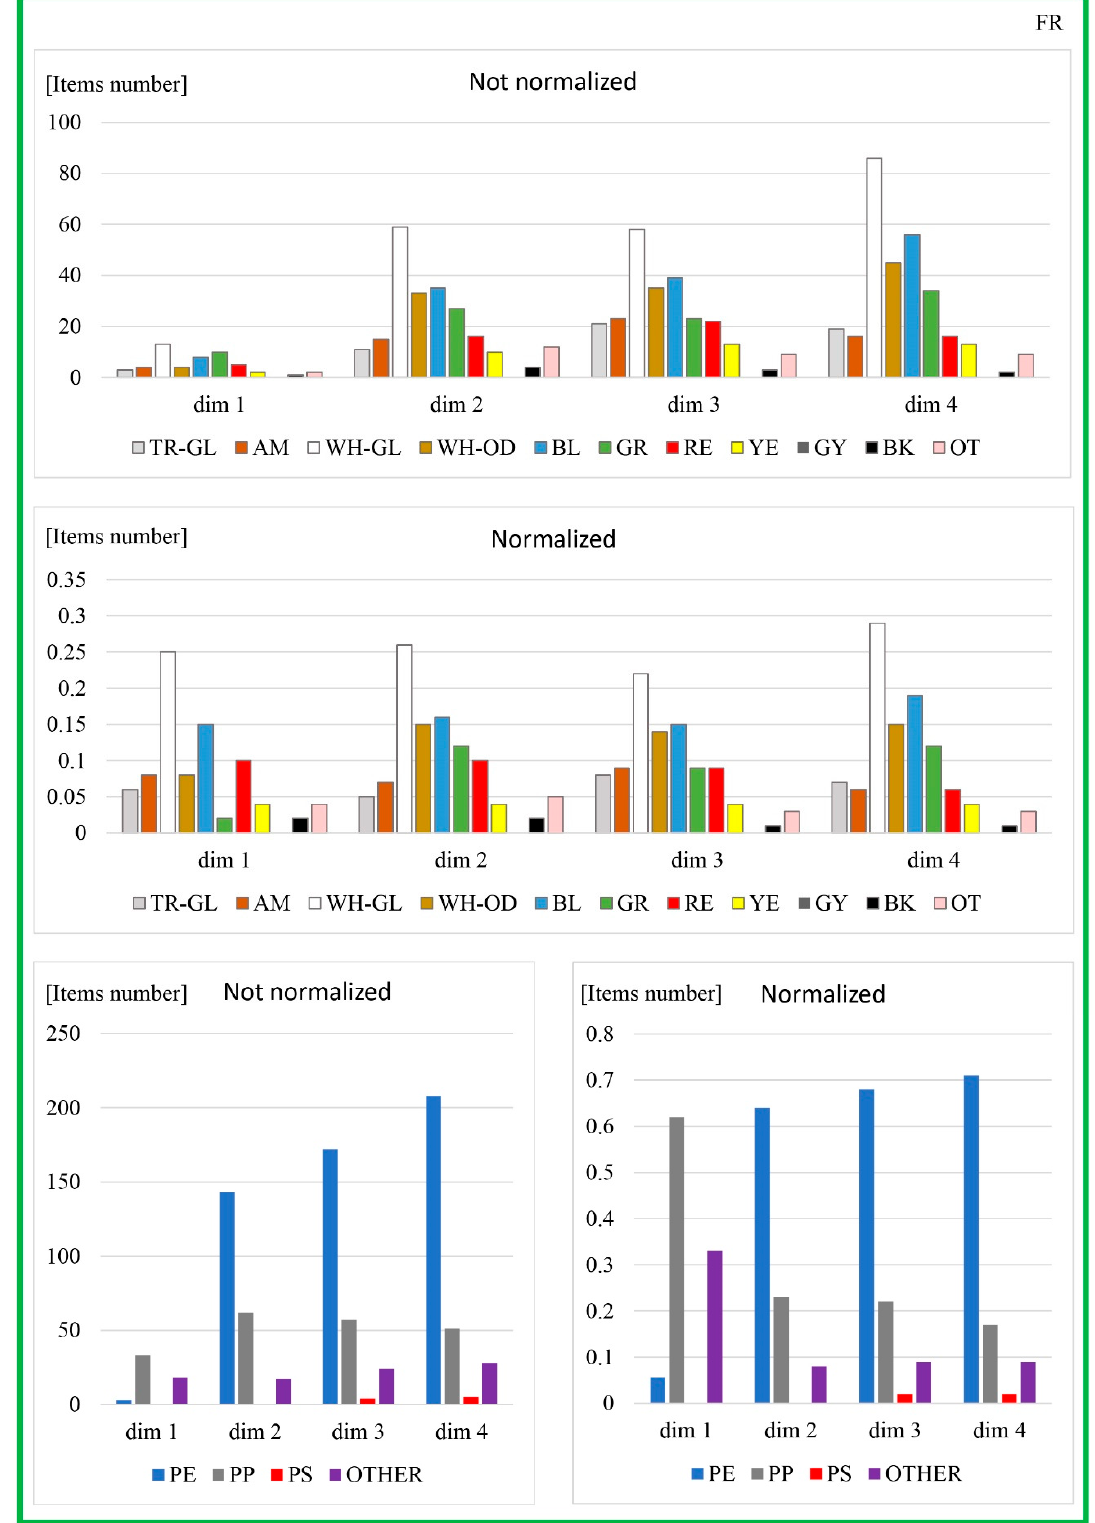
Figure 9. Distribution of polymeric types and color abundances in the different dimensional classes, for the sub-sample of which the polymeric characterization has been made. Two of the graphs reports values normalized to the total number of particles for each dimensional class: the very small differences, in percentage, amongst the color distribution of the four dimensional classes, clearly emerge. For polymeric type distribution, instead, larger differences are visible, specially between PP and PE. Data are available in Table S8 in Supplementary Material.